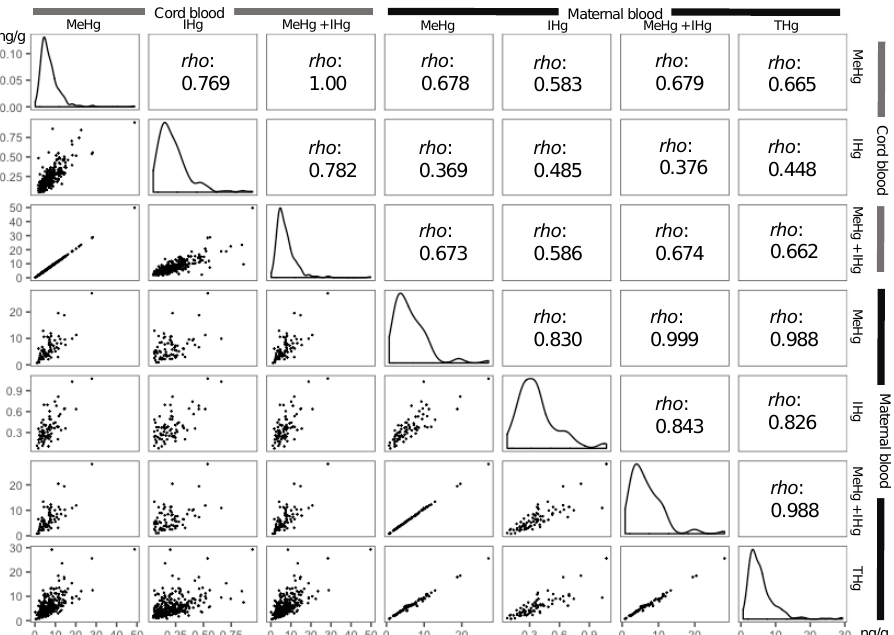
Figure 3. Correlation matrix plots between mercury concentrations (ng/g) in cord blood and maternal blood. Correlation matrix plots show the distribution, ‘ rho ’ of Spearman’s correlation coeffi-cients, and scatter plots. LC-ICP-MS: liquid chromatography-inductively coupled plasma mass spectrometry. Mercury speciation results obtained by LC-ICP-MS are shown as methylmercury (MeHg), inorganic mercury (IHg), and the sum (MeHg + IHg). Total mercury (THg) results ob-tained by ICP-MS are showed as THg. The plots of more than method detection limit are shown. Figure 4 shows the relationships between the cord blood:maternal blood ratios of IHg and MeHg. The median (25th–75th percentile) ratios of MeHg and IHg were 1.3 (0.8–1.6) and 0.5 (0.4–0.8), respectively. The cord blood:maternal blood ratio of IHg was positively associated with that of MeHg.